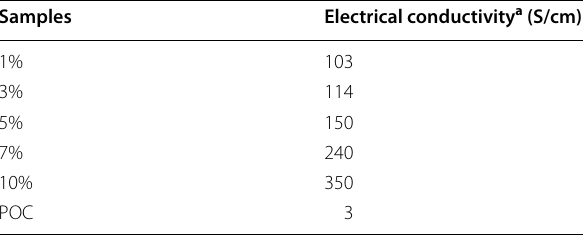
Table 2 Electrical conductivity of POC/Cr NCs